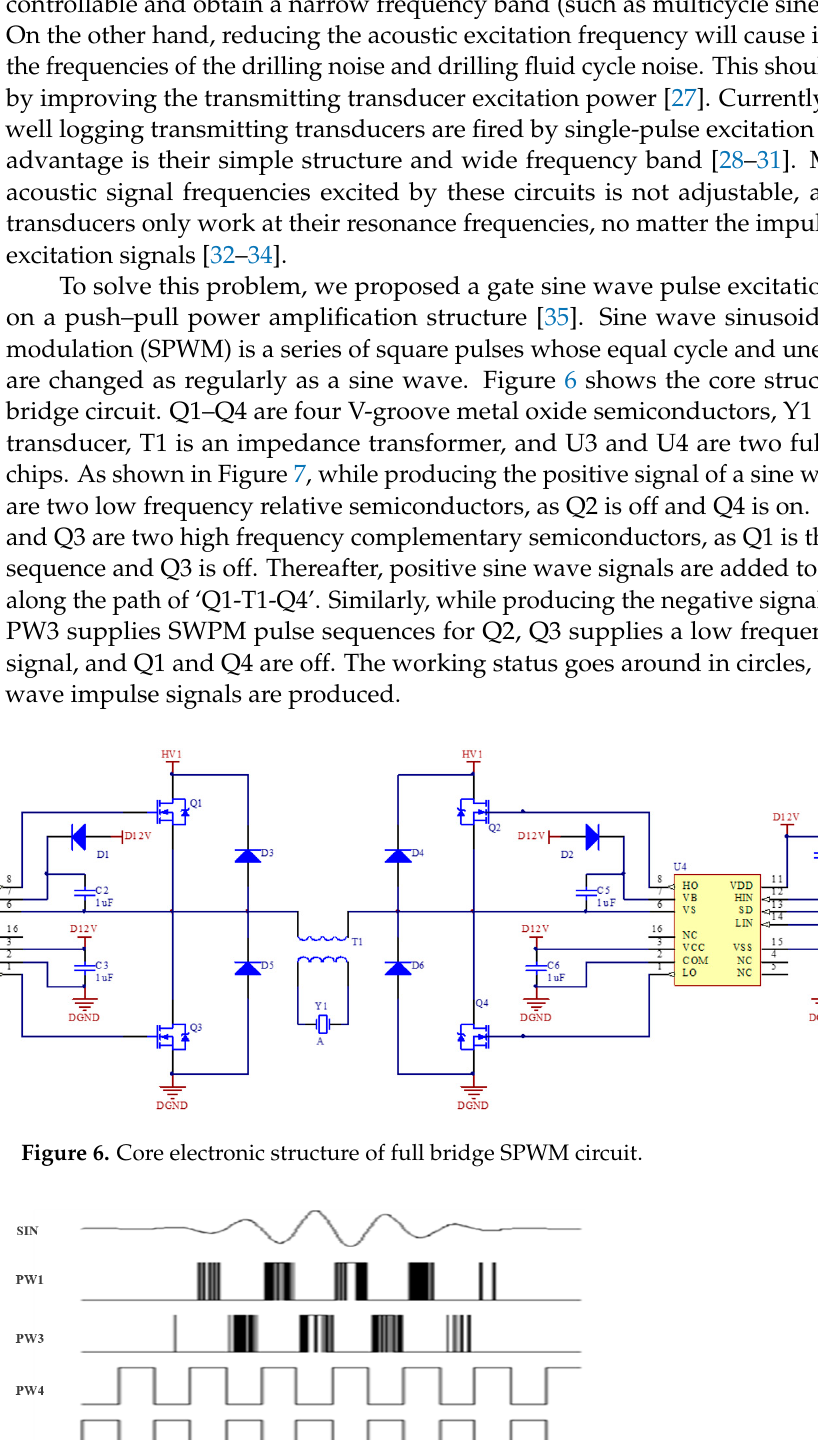
( b ) Figure 8. Time ‐ domain ( a ) and spectrum waves ( b ) excited by SPWM excitation circuit.